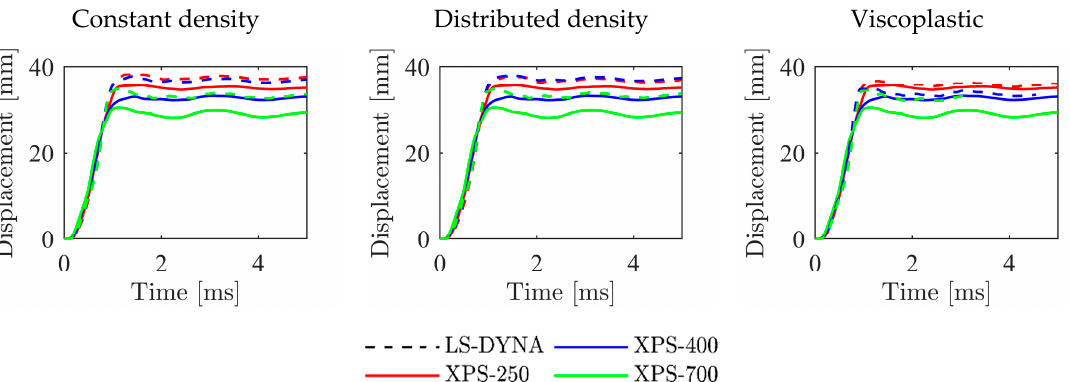
Figure A5. Comparison between experimental and numerical midpoint displacements for tests with 12 bar firing pressure.